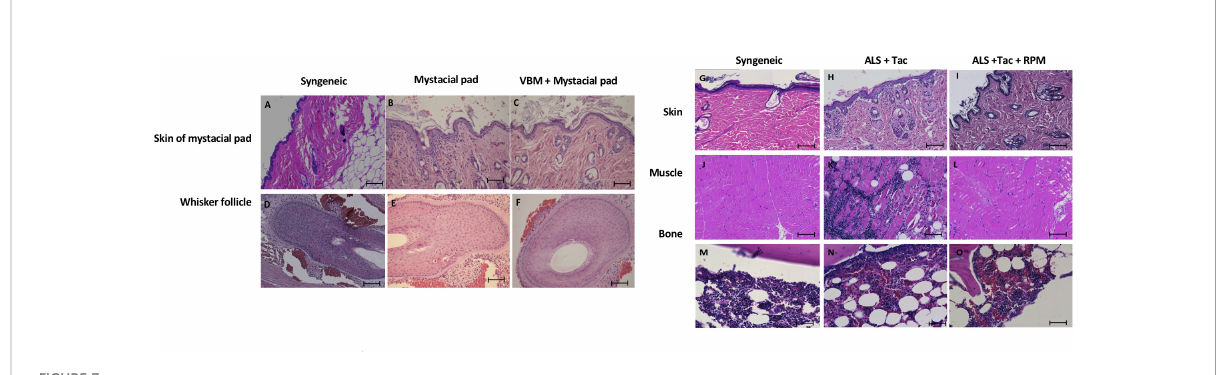
FIGURE 7 Histology of the secondary mystacial pad transplant showed graft acceptance. (A – F) Histopathology of the mystacial pad allograft. (G – O) Histopathology of the vascularized bone marrow allograft. Magni fi cation ×100. Scale bar: 100 m